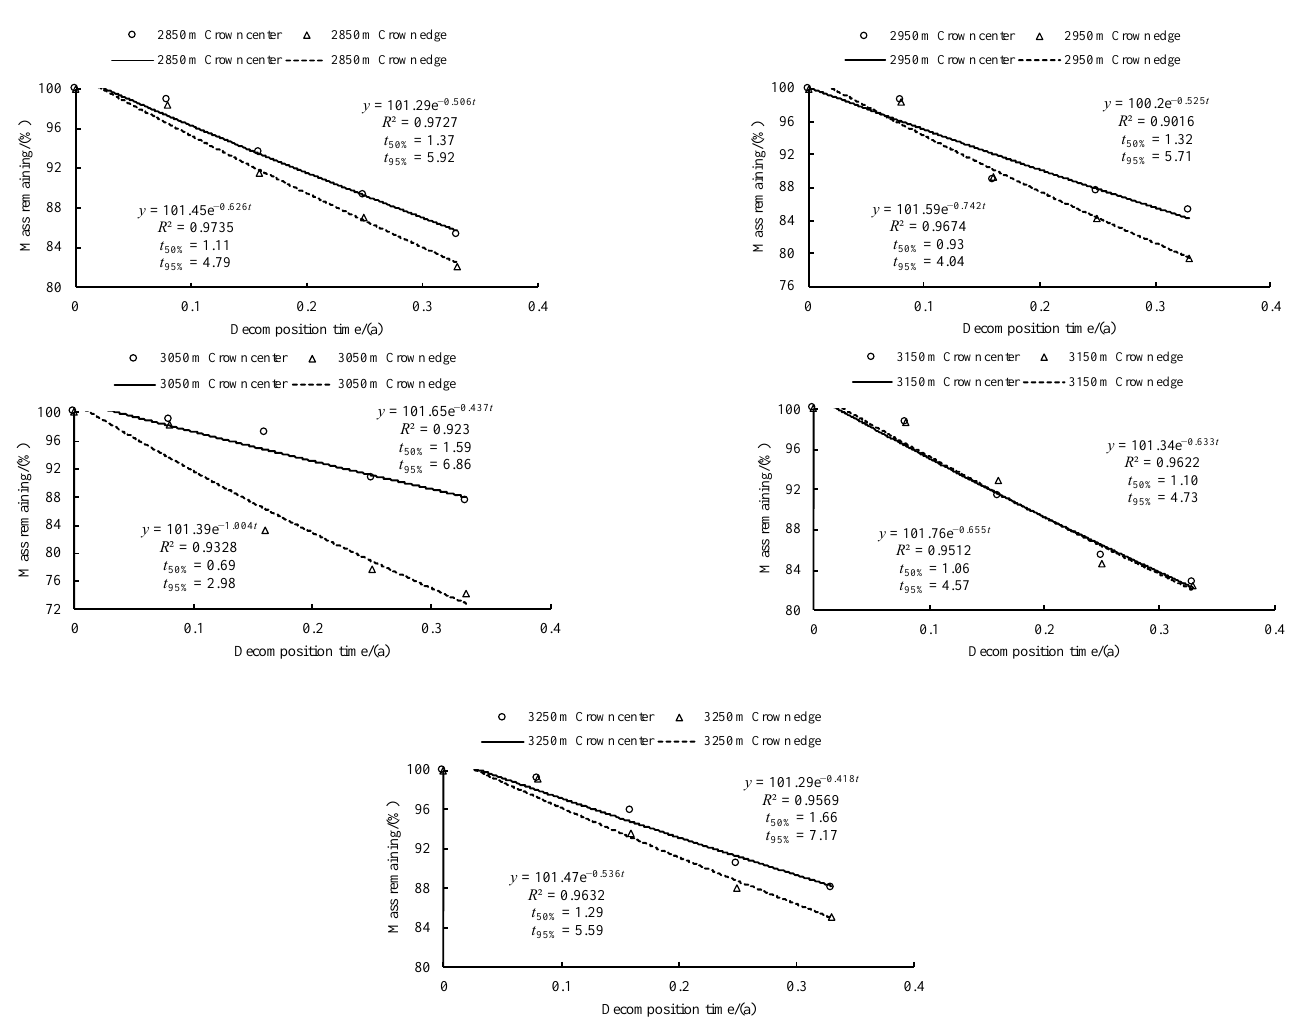
Figure 8. Decomposition model of Qinghai spruce leaf litter from CC and CE at different altitudes in the growing season.